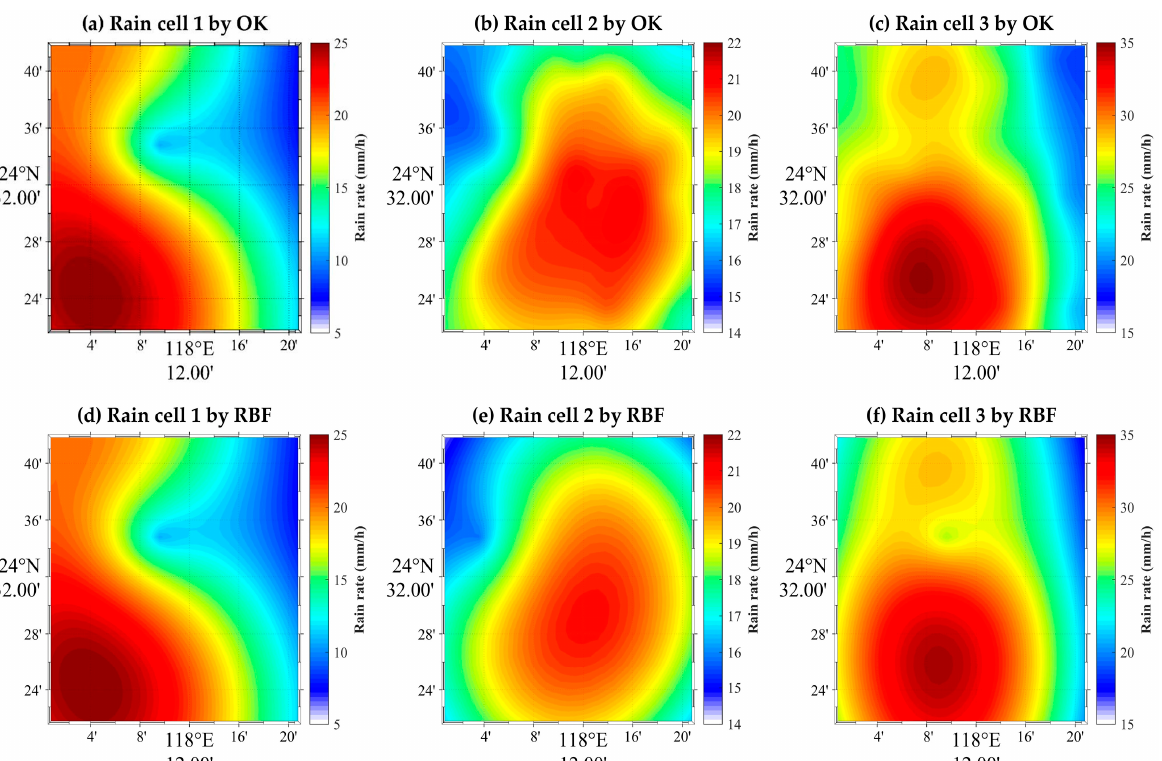
Figure 7. The results of the joint network of ESLs and HMLs retrieving the set of different rain cells. ( a – c ) represent the rain cells reconstructed by the OK algorithm, and ( d – f ) represent the rain cells reconstructed by RBF neural network.